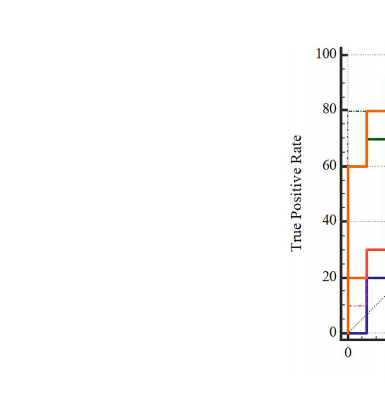
FIGURE 5 | LR-classi fi er in the validation